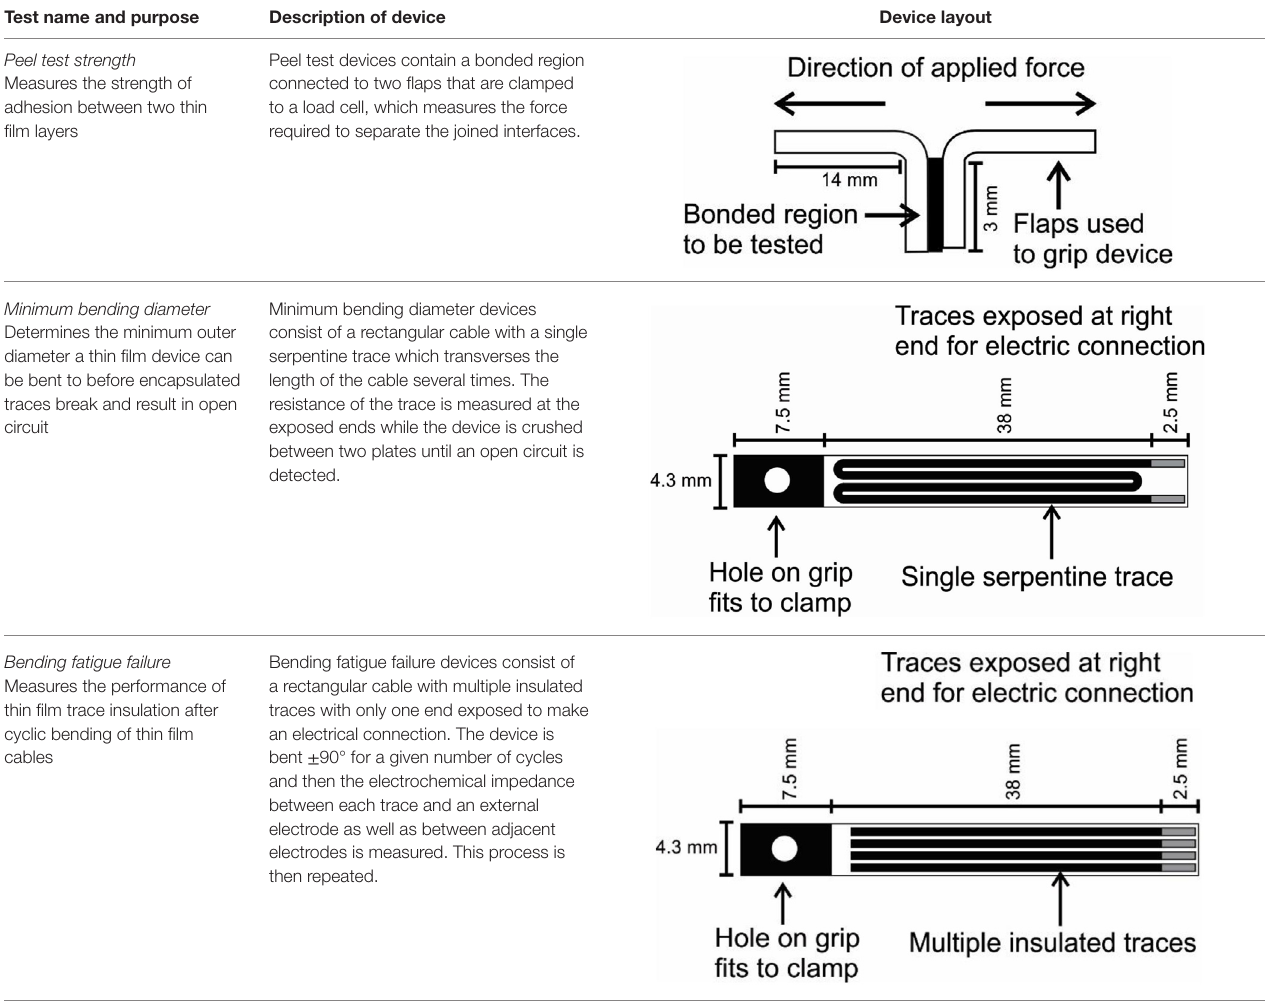
TaBle 1 | summary of devices and tests used to measure peel strength, minimum bending diameter, and bending